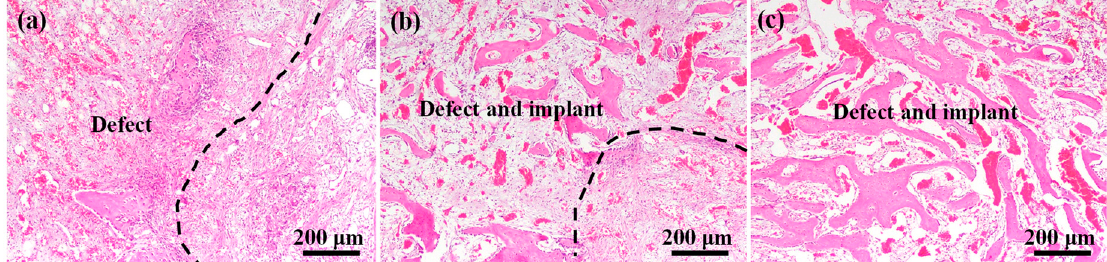
Figure 7. Images of H&E-stained bone tissue 4 weeks after implantation: ( a ) blank, ( b ) control, and ( c ) α -CSH samples.